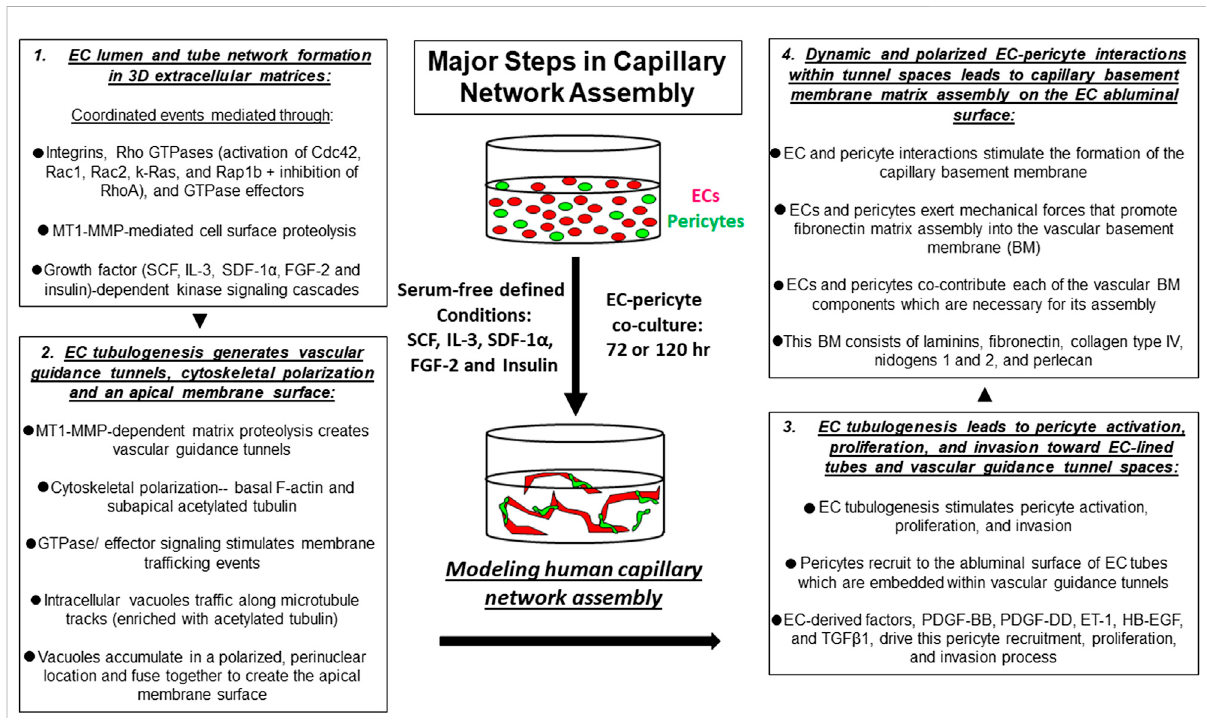
Key steps controlling capillary tube network assembly in 3D extracellular matrices. In vitro model systems have been developed to mimic the normalprocessofhumancapillarynetworkassemblyina3Dmatrixenvironment.Usingthisde fi nedsystem,serum-freeconditions,andtheaddition of a combination of fi ve growth factors ( “ Factors ” ) consisting of SCF, IL-3, SDF-1 α , FGF-2 and insulin allows for human ECs and pericytes to co- assemble into capillary networks over